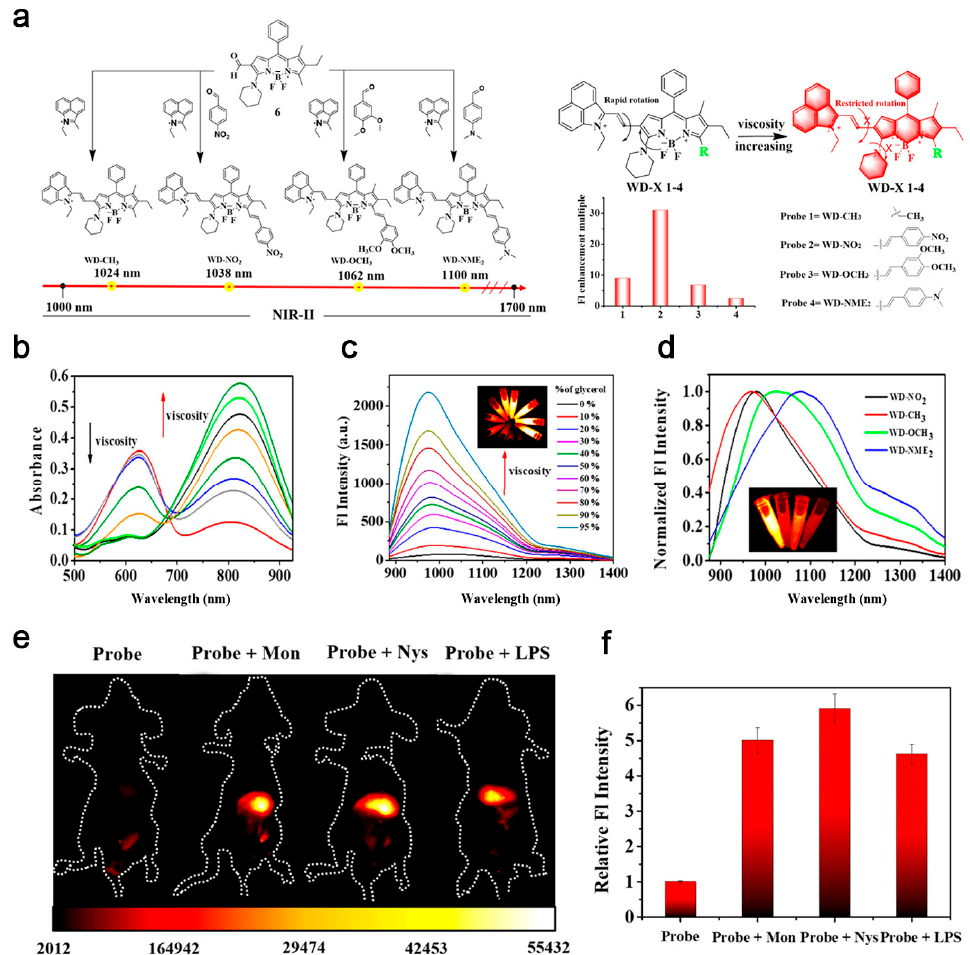
Figure 9. ( a ) Schematic illustration of the design strategy of viscosity-activatable fluorescence probes WD-X (WD-CH 3 , WD-NO 2 , WD-OCH 3 , and WD-NME 2 ). Chemical structures and synthetic routes of WD-X (left) and mechanism of WD-X for viscosity-activatable NIR-II fluorescence imaging (right). ( b ) Electronic absorption and ( c ) fluorescence spectra of WD-NO 2 (20 µM) in the ethanol-glycerol system with different viscosities. Inset shows fluorescence images of WD-NO 2 in the ethanol-glycerol system with different glycerol ratios. ( d ) Normalized NIR-II fluorescence spectra of WD-X (WD-NO 2 , WD-CH 3 , WD-OCH 3 , and WD-NME 2 ) in the system with 95% glycerol. Inset shows the corresponding fluorescence images under the irradiation of 808 nm (40 mW/cm 2 ) laser. ( e ) Fluorescence imaging and ( f ) normalized relative fluorescence intensity of mice after treatment with WD-NO 2 , WD-NO 2 + Mon, WD-NO 2 + Nys, and WD-NO 2 + LPS. Reproduced with permission [131]. Copyright 2020, American Chemical Society.